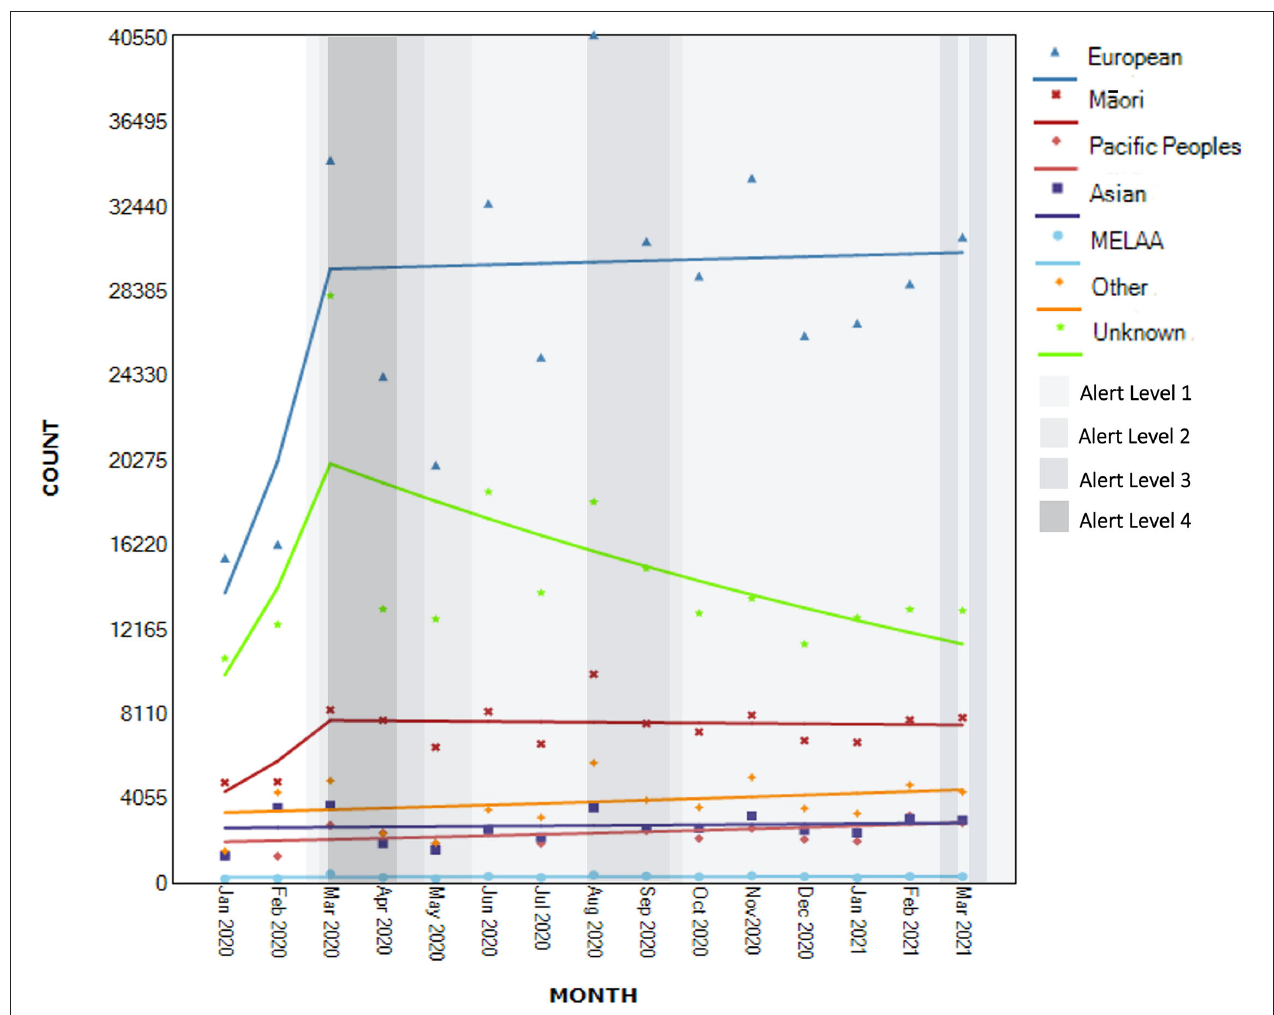
FIGURE 7 | Segmented regression analysis of contacts to national helplines by ethnicity ( N known = 664,897).